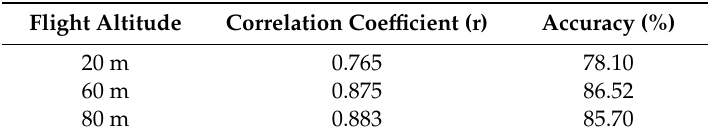
Table 5. Correlation and accuracy value of tree height.